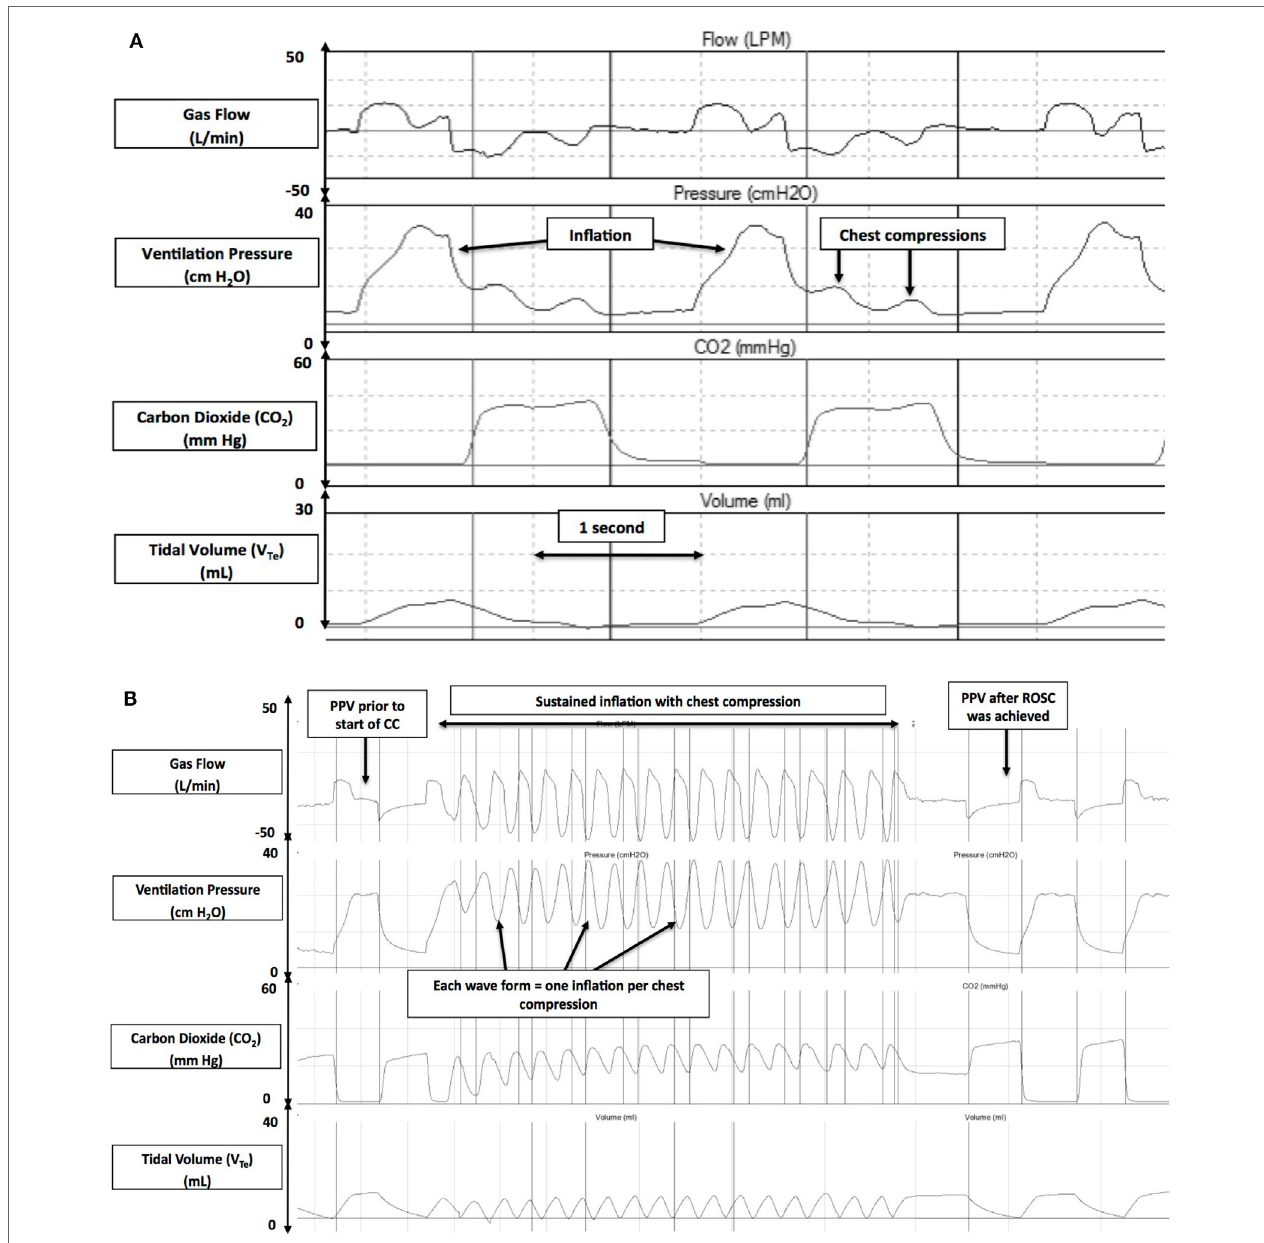
FiGURe 1 | Respiratory waveforms during cardiopulmonary resuscitation in the 3:1 compression:ventilation ratio (3:1 C:V) (A) and chest compression (CC) + sustained inflation (SI) (B) groups (gas flow, airway pressure, ECO 2 , and tidal volume). Reproduced with permission from Schmölzer et al.